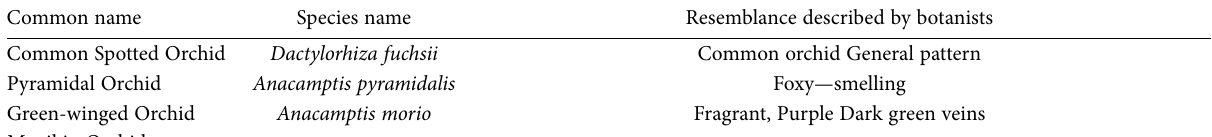
Table 1. Orchid species in which the flowers are similar to animal structures and other unexpected shapes. Common and scientific names according to Blamey et al. 2013, “Wild flowers of Britain and Ireland”. The words used and the statements made by the authors are in quota- tion marks.